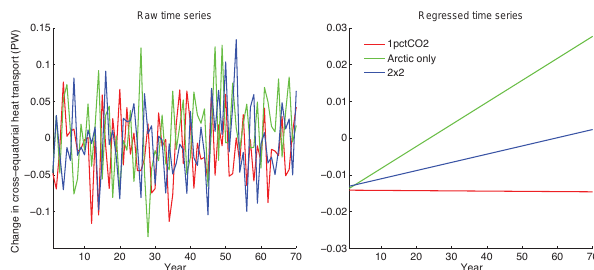
Figure A2. Similar to Fig. A1 but for GISS ModelE2 (the evalua- tion model). Left panel shows annually averaged change from the preindustrial control in cross-equatorial energy transport by the at- mosphere (Eq. A1). Right panel shows ordinary least-squares linear regressions performed on those time series. All values are annually averaged and expressed in